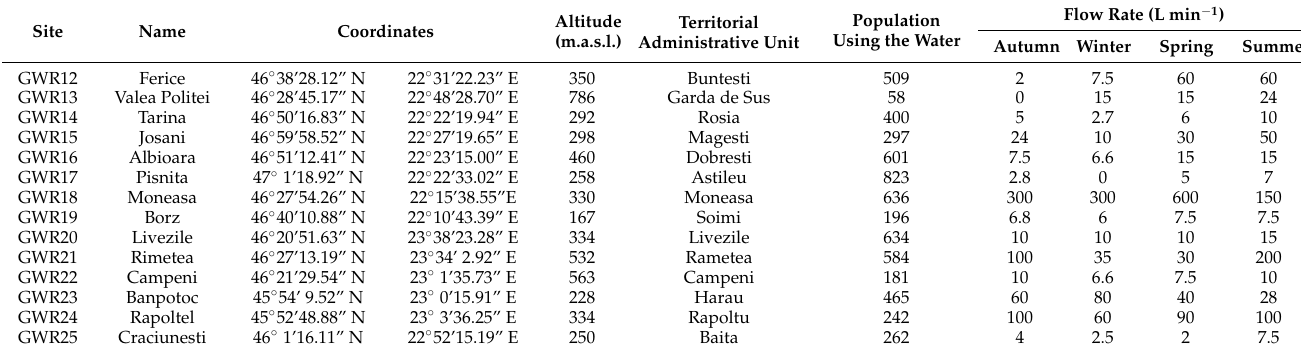
Table 1. The studied karst water sources in the Apuseni Mountains with details on their geographic localization, flow rate in different seasons and the estimated number of people that use the